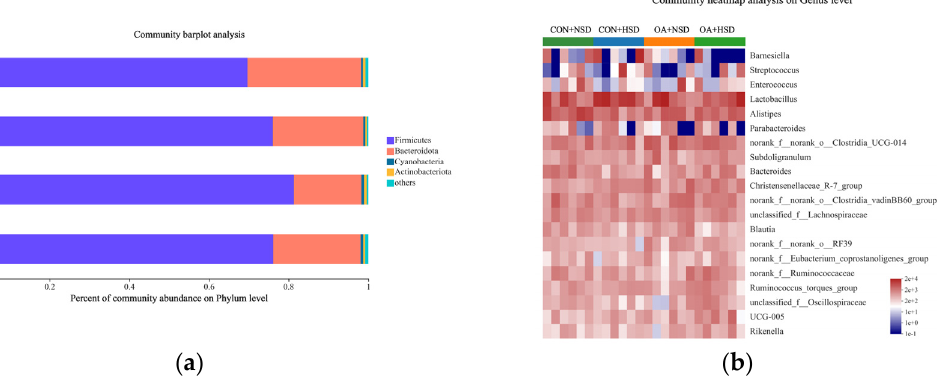
Figure 3. Effects of organic acids on the distribution of cecal bacteria at the phylum ( a ) and genus ( b ) levels in broilers under high stocking density in the grower phase. CON+NSD, broilers drank normal water under normal stocking density; CON+HSD, broilers drank normal water under high stocking density; OA+NSD, broilers drank organic acid-supplemented water under normal stocking density; OA+HSD, broilers drank organic acid-supplemented water under high stocking density.